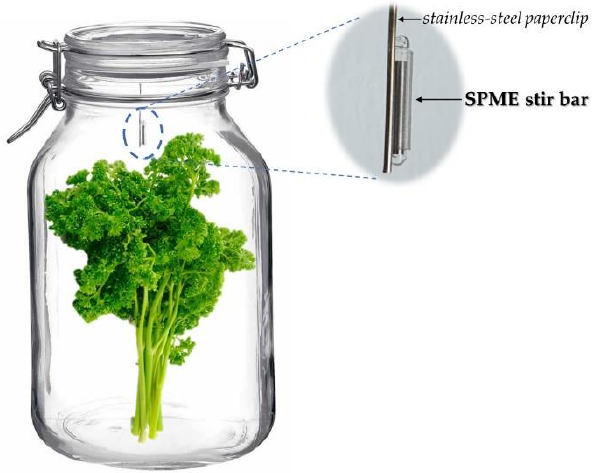
Figure 1. Sampling system for volatile organic compounds (VOCs) of fresh aromatic herbs with static headspace solid-phase microextraction (SPME).